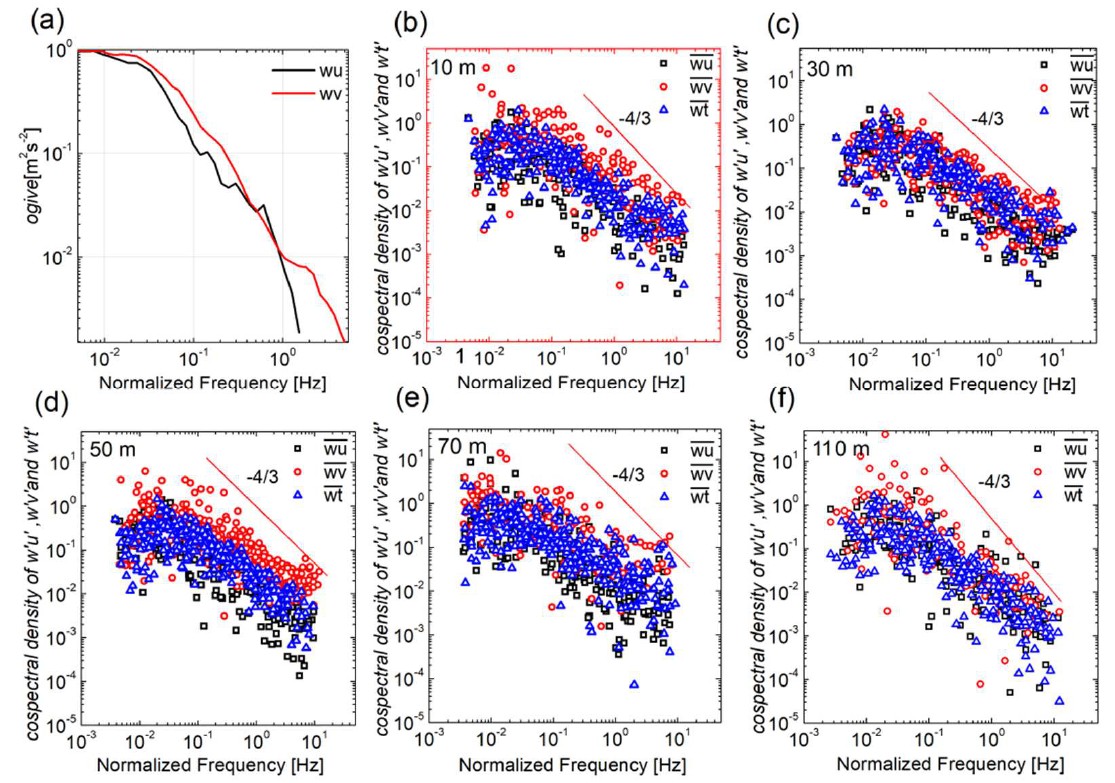
Figure 2. ( a ) Cumulative frequency curves (ogive) of the vertical velocity w with the along − wind u and cross − wind v components. The cospectra densities of the vertical velocity ( w ) with the along-wind ( u ) and cross-wind ( v ) components and ultrasonic virtual temperature ( T ) at ( b ) 10 m, ( c ) 30 m, ( d ) 50 m, ( e ) 70 m, and ( f ) 110 m. Ten-minute averaged data are for Typhoon Maria (2018) from 0000 local standard time (LST) 10 July to 0000 LST 12 July 2018. (5) A turbulence (co)spectrum check.